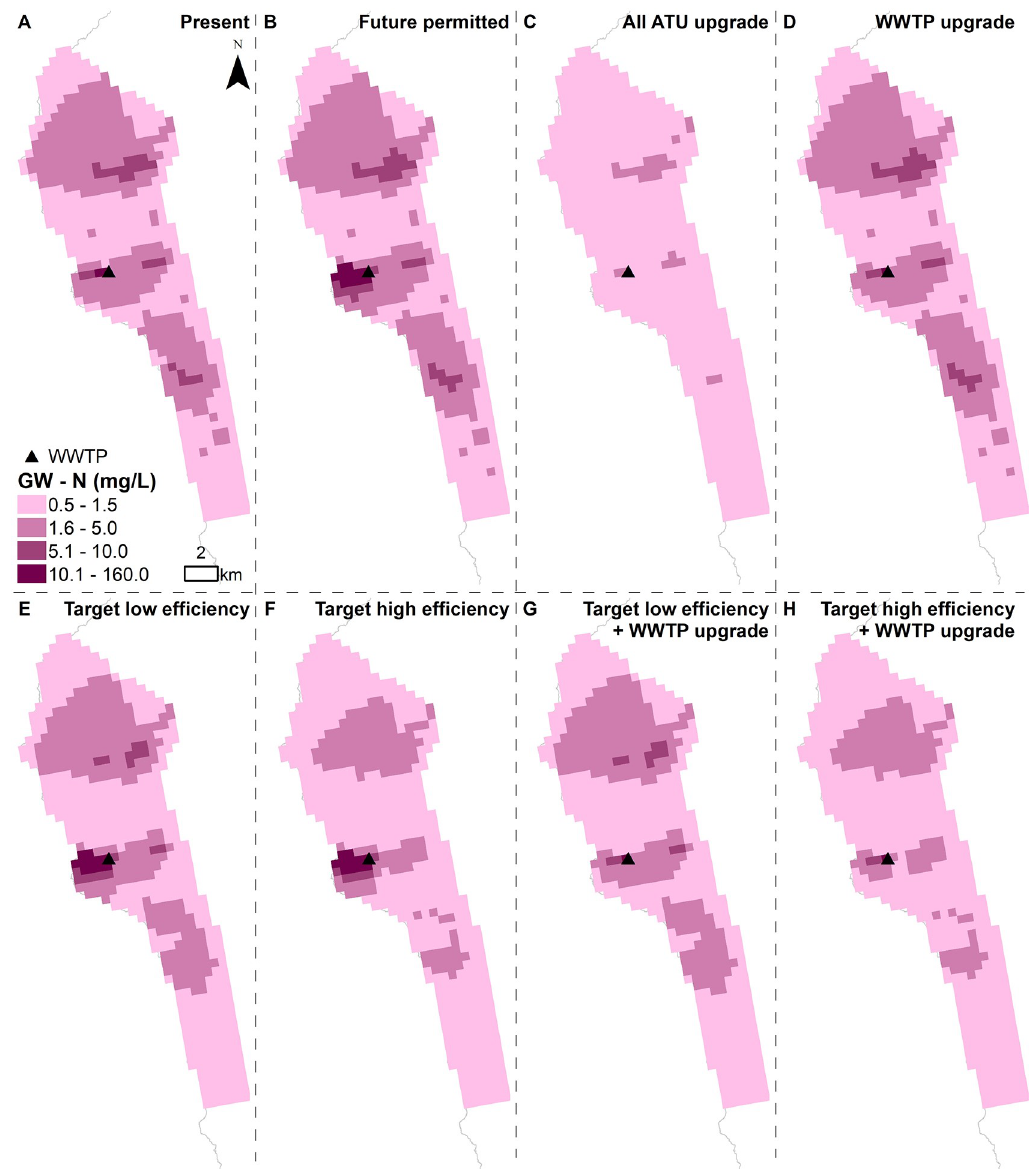
Fig 3. Simulated groundwater N concentrations for (A) current conditions and (B-H) all scenarios. Maps display results from the first layer of the groundwater model, where the bottom of the layer is set to 1 m below mean sea